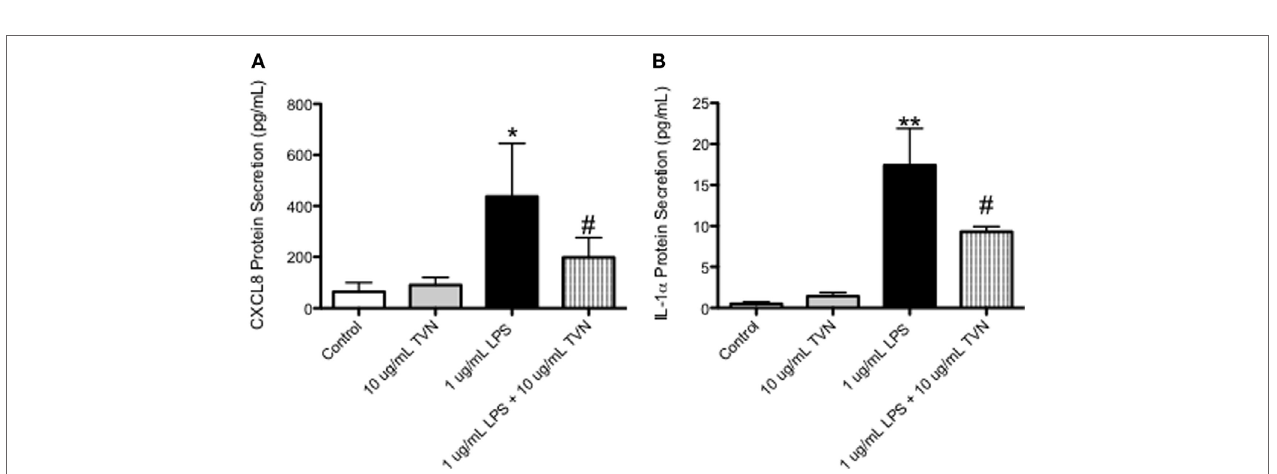
FigUre 6 | Tylvalosin treatment inhibits CXCL8 and IL-1 α protein secretion in LPS-stimulated macrophages. Porcine macrophages were treated with control vehicle (10% HI-FBS in IMDM) or tylvalosin (10 μg/mL), in the presence of absence of LPS (1 μg/mL) for 2 h. Supernatants were collected and submitted to multiplex analysis of secreted chemokines/cytokines. Using this bead-based fluorescent assay and the standard curves it generates secreted protein was measured and values are expressed as picograms/milliliter. CXCL8 (a) and IL-1 α (B) protein secretion was inhibited by tylvalosin in LPS-stimulated macrophages. Data represent mean ± SEM ( n = 3–4/group). * P < 0.05, ** P < 0.01 versus unstimulated control; # P < 0.05 versus LPS-stimulated macrophages.